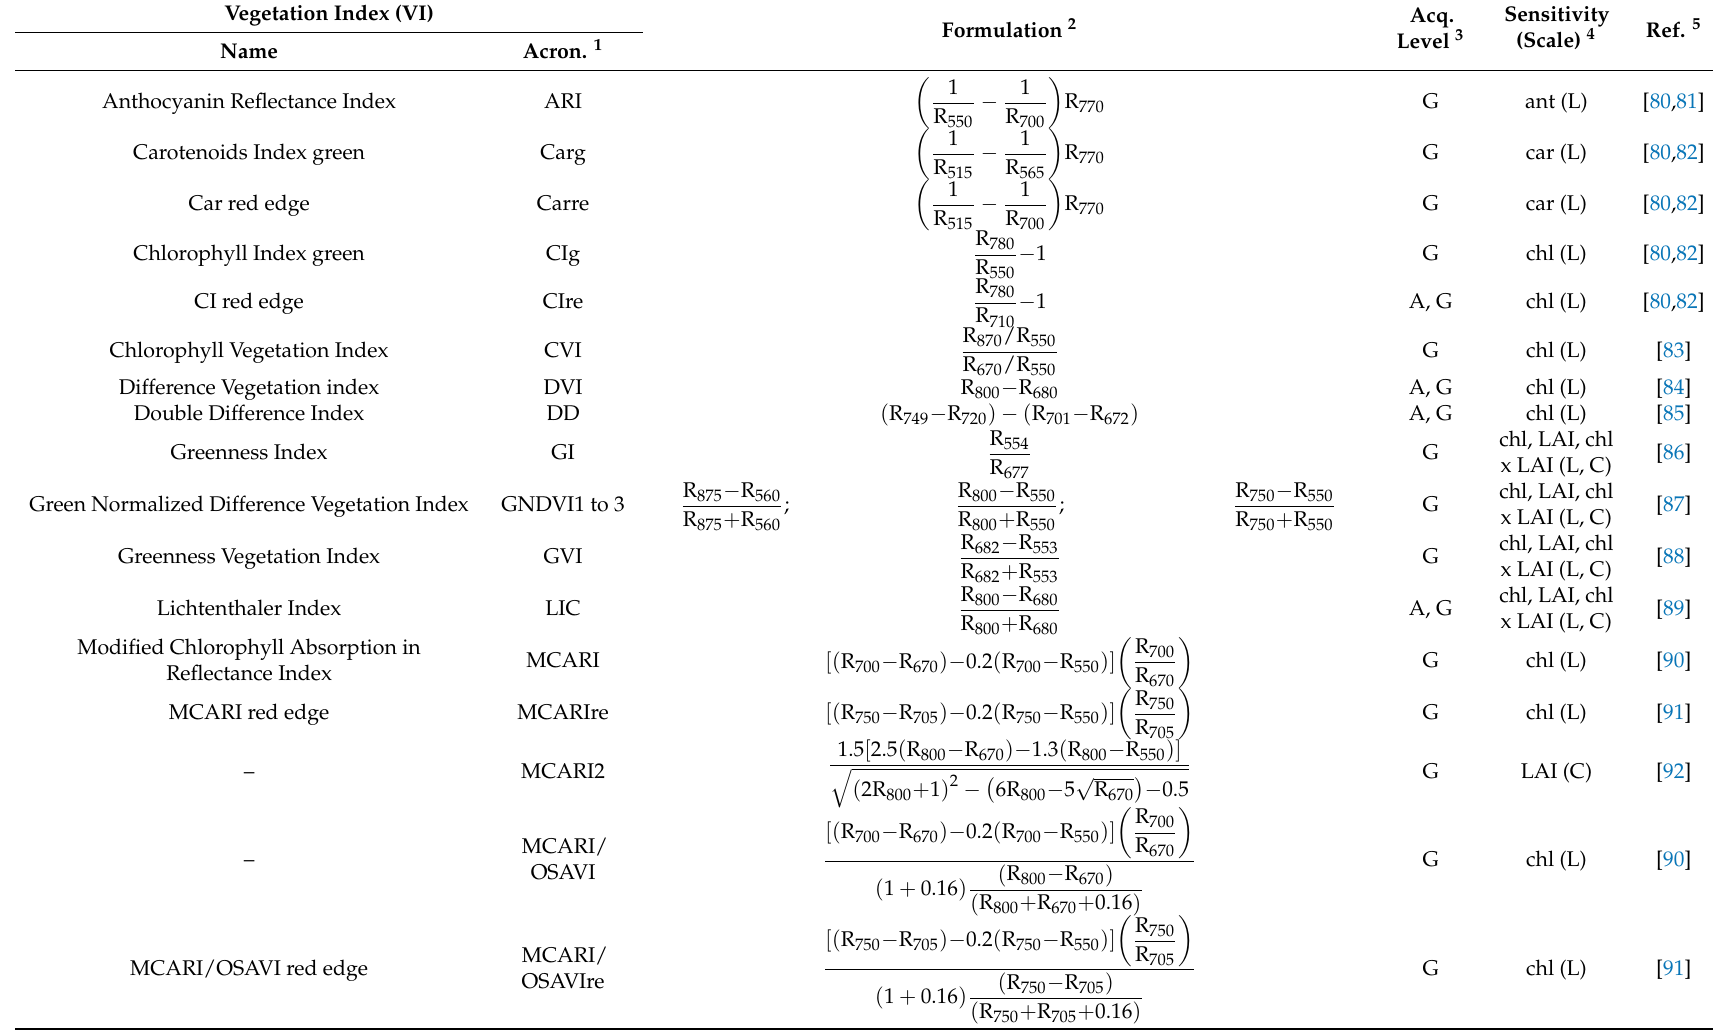
Table A2. Vegetation indices used in this